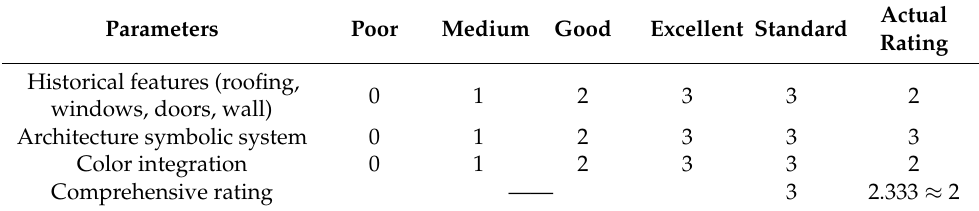
Table 1. Historic landscape evaluation assessment of Han family residence in Siqiao